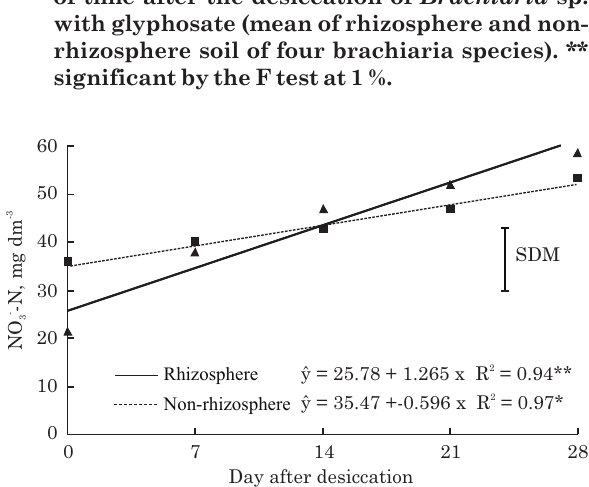
Figure 4. Nitrate (NO 3- -N) in the rhizospheric and non- rhizospheric soils of Brachiaria sp. as a function of time after desiccation with glyphosate (mean of four brachiaria species). * and ** significant by the F test at 5 and 1 %, respectively. The vertical bar represents the standard deviation of the mean (SDM) obtained from the t test (LSD) at 5 %.